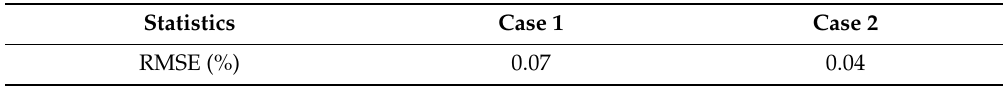
Table 9. RMSE of DNN model for predicted crusher utilization over 10 working days (case 1) and predicted value excluding 7 November (case 2).